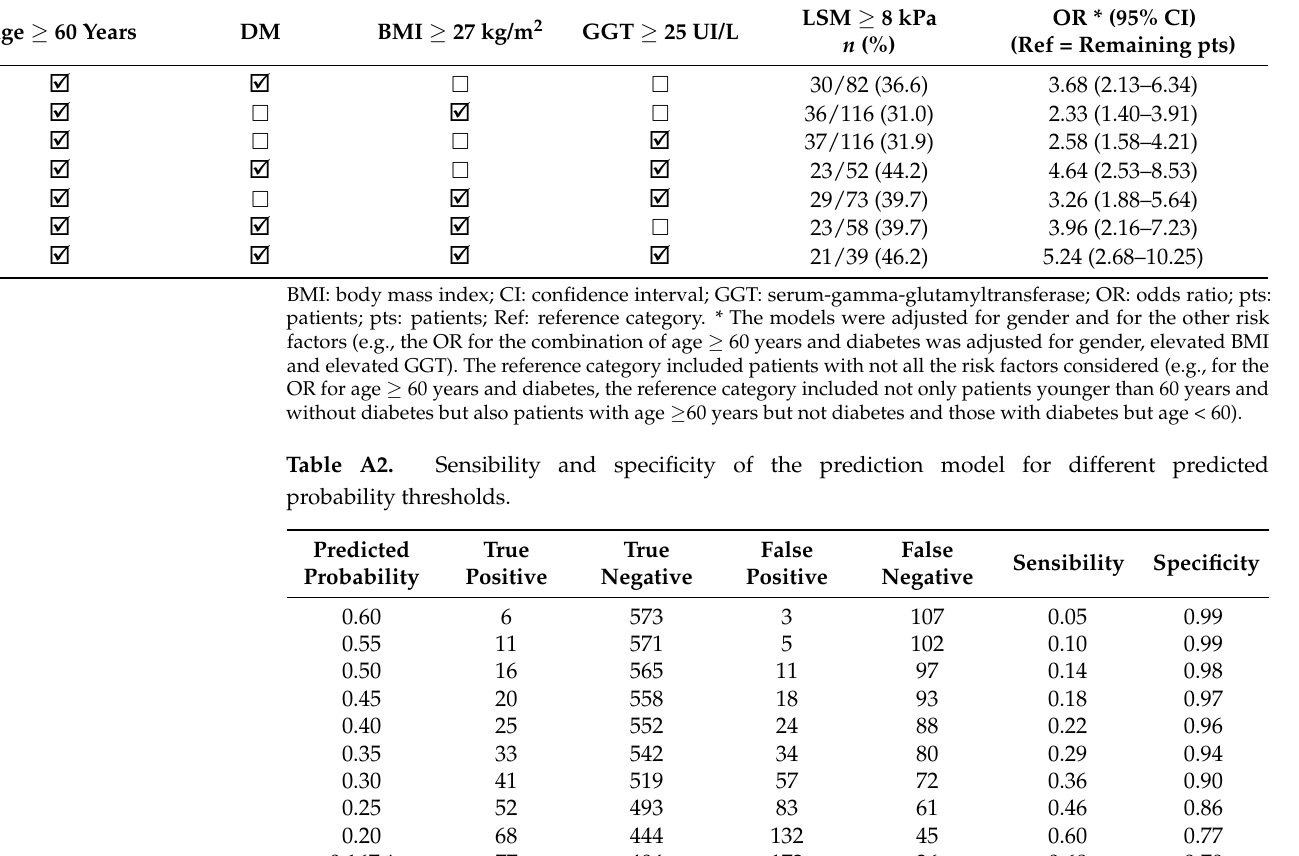
Table A1. Odds ratios of increased liver stiffness (LSM) by transient elastography (i.e., LSM ≥ 8 kPa) for combination of risk factors in 699 patients with nonalcoholic fatty liver disease (NAFLD) and FIB-4 score < 1.3.